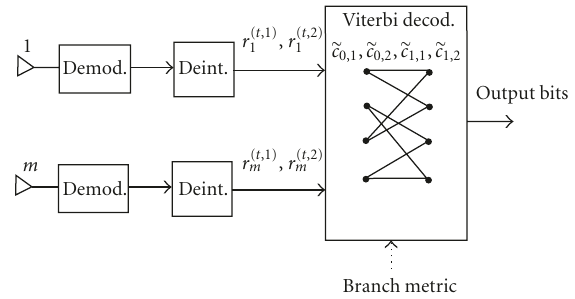
Figure 3: Receiver structure for the proposed P-STCs in coop- erative communications. The Viterbi decoder is the same as for the single convolutional code adopted in transmission, but the metric on the generic branch is, for example, for n = 2 and R = (cid:4) (cid:10) m | r ( t ,1) − 1, E s ( h ( t ) 0,1, s (cid:9) c 0,1 + h ( t ) 0,2, s (cid:9) c 0,2 ) | 2 + | r ( t ,2) s s = 1